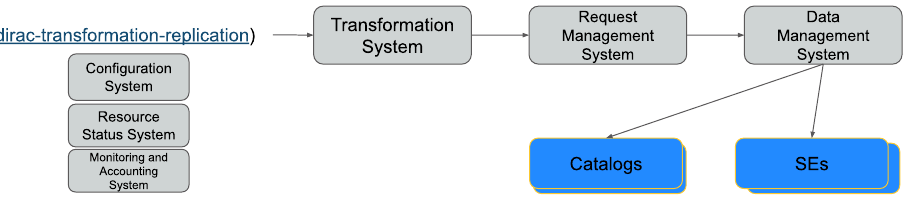
Figure 3. Datasets management through DIRAC Transformation, Request Management and Data Man- agement